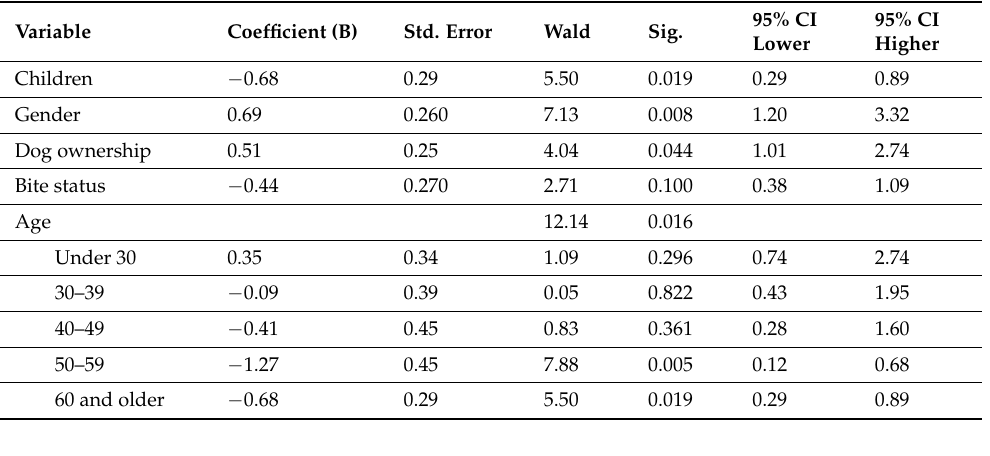
Table 2. Results of the binary logistic regression model predicting support of breed ban as a function of child status, gender, dog ownership, bite status, and age.